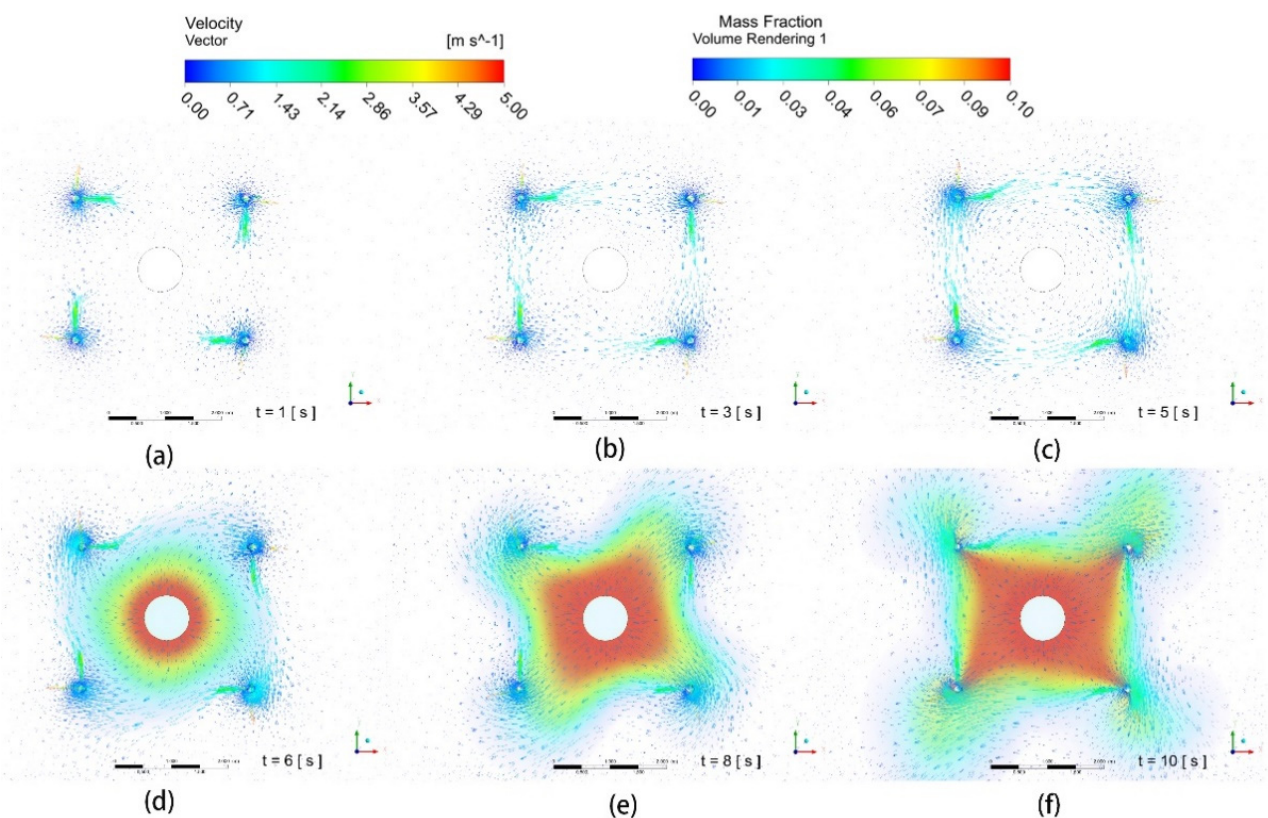
Figure 16. The superposition diagram of velocity vector and pollutant mass fraction in transient simulation of case 1: ( a ) time = 1 s; ( b ) time = 3 s; ( c ) time = 5 s; ( d ) time = 6 s; ( e ) time = 8 s; ( f ) time = 10 s.